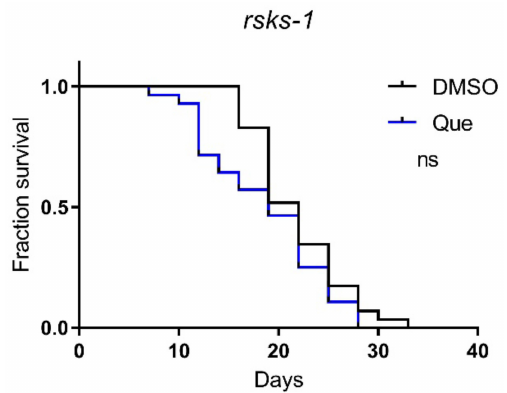
Figure 5. Quetiapine-induced lifespan reduction is dependent on mTOR signaling. Survival curves of mutant rsks-1 ( n = 30 worms per group) treated with 100 µ M of quetiapine or DMSO at 20 ◦ C. Data were analyzed by using the log-rank test (ns: no significant difference with p > 0.05). Experiments were performed in at least two independent biological replicates.